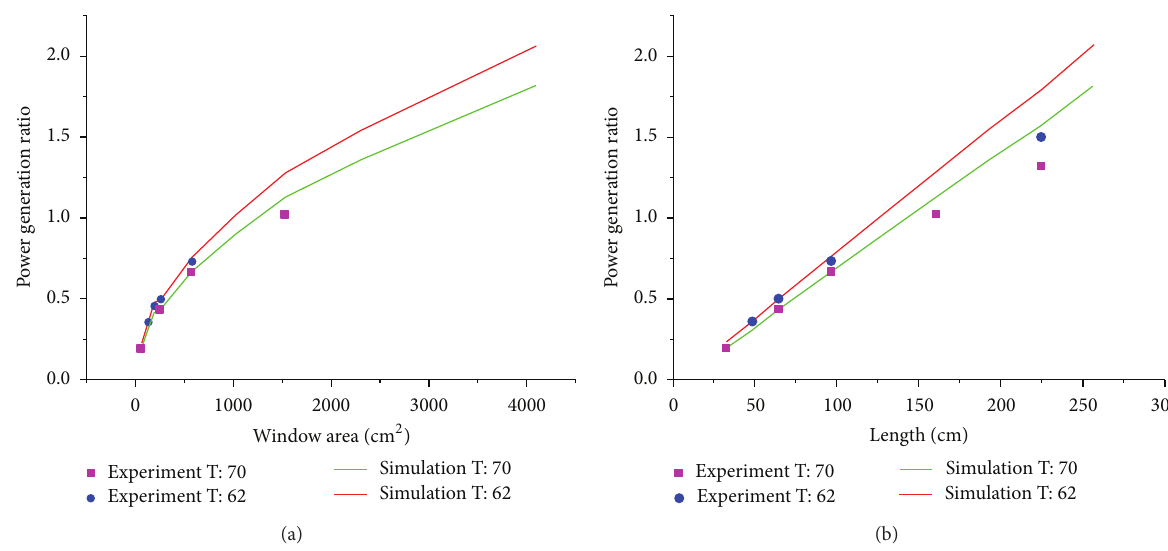
Figure 6: Comparison of power generation ratio of diffusive solar cell windows with different sizes between simulation and experiment in terms of (a) window area and (b) window perimeter.